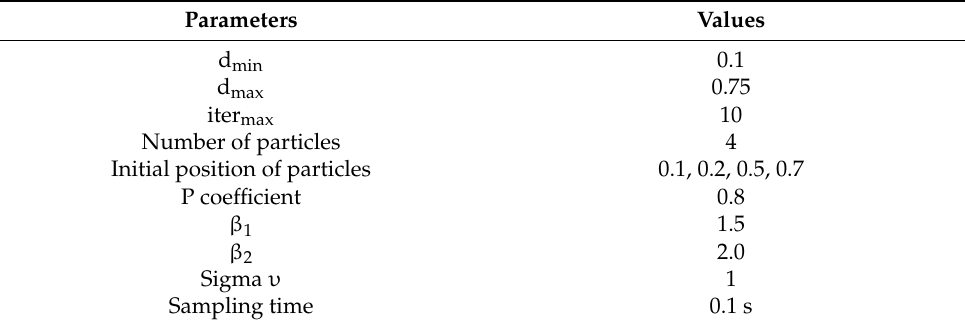
Table 3. Parameter setting of the proposed algorithm.